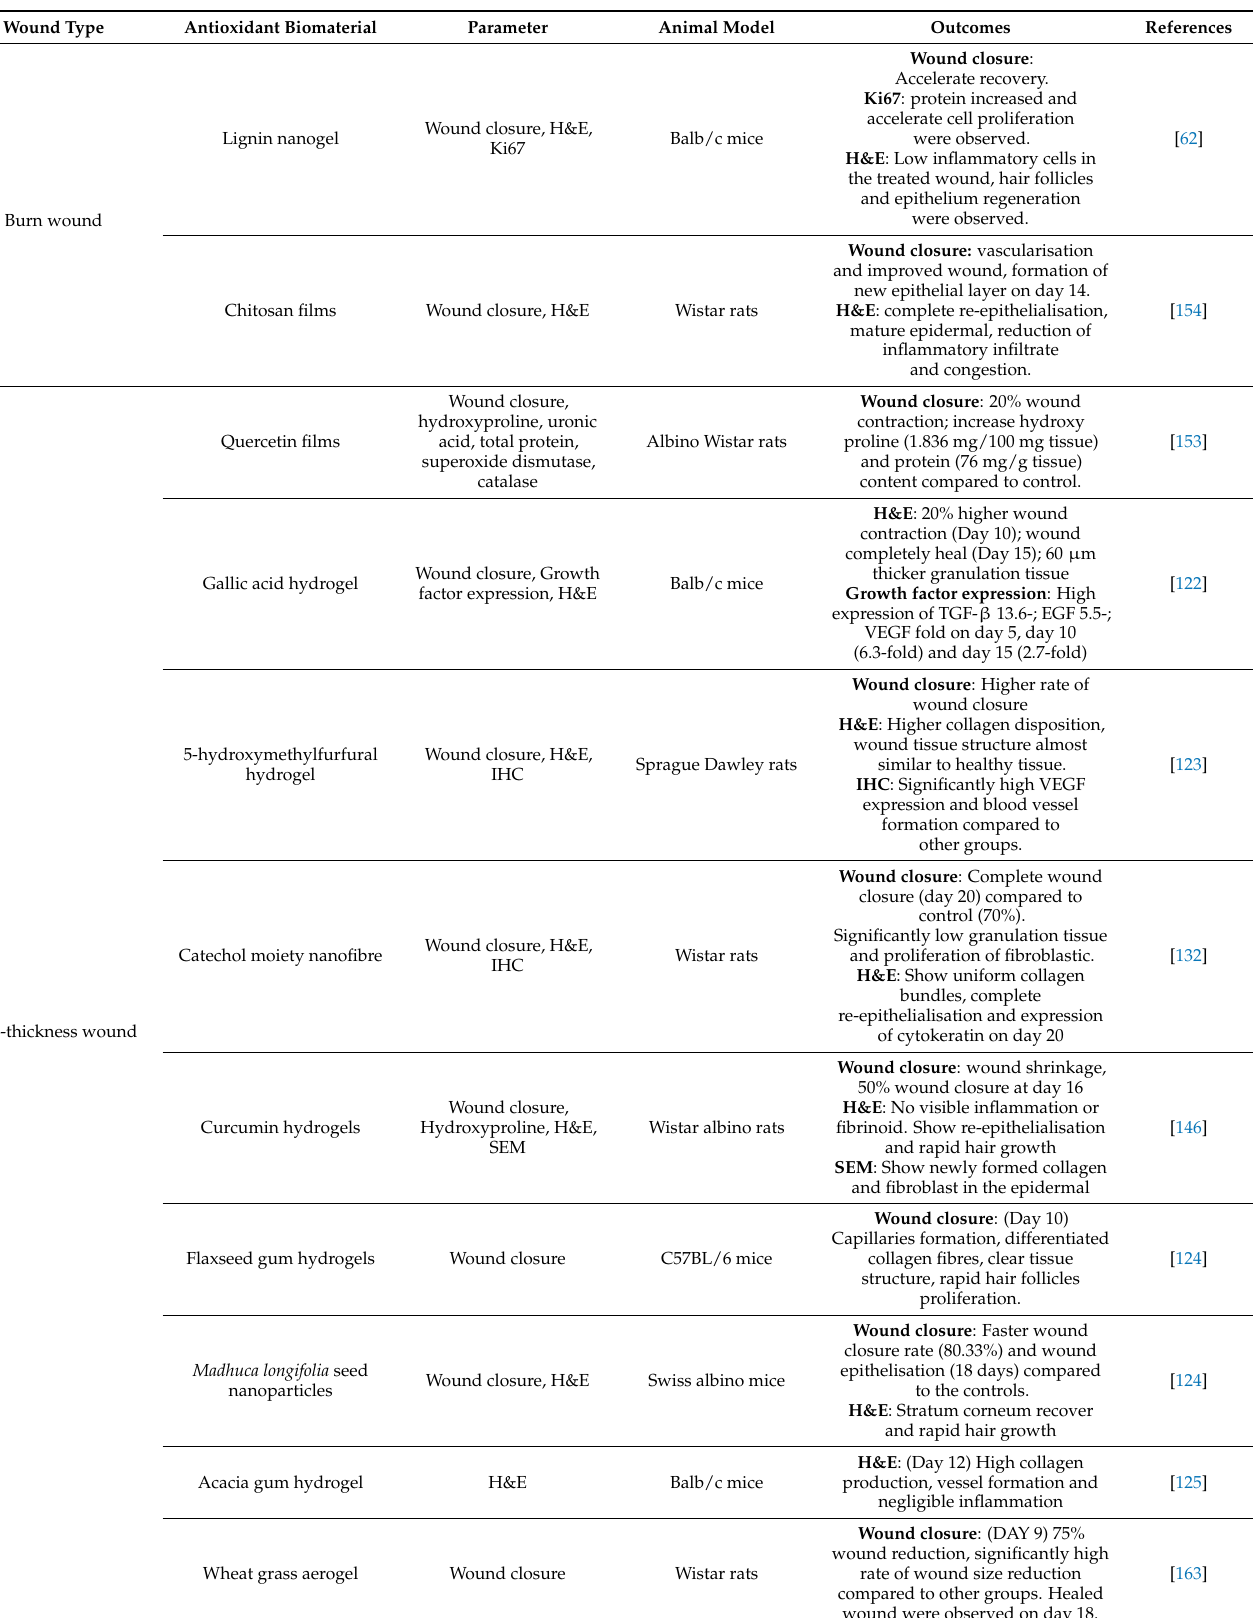
Table 5. The in vivo studies of antioxidant biomaterials for wound healing